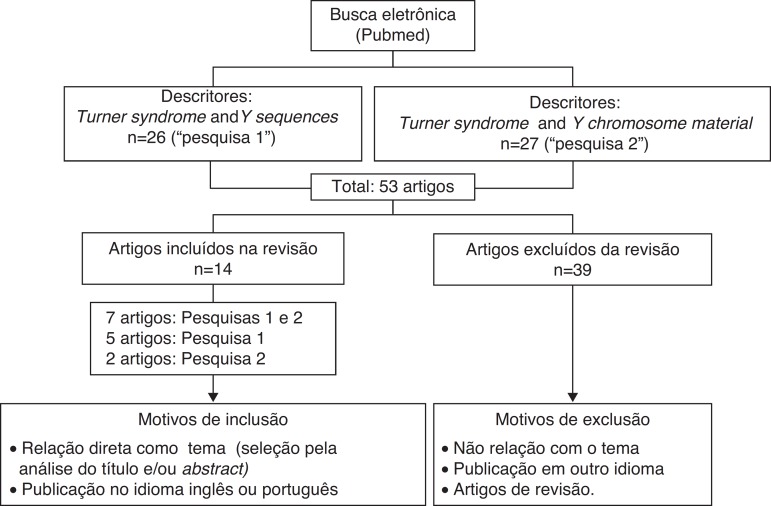
Representação do método e resultados da busca eletrônica.